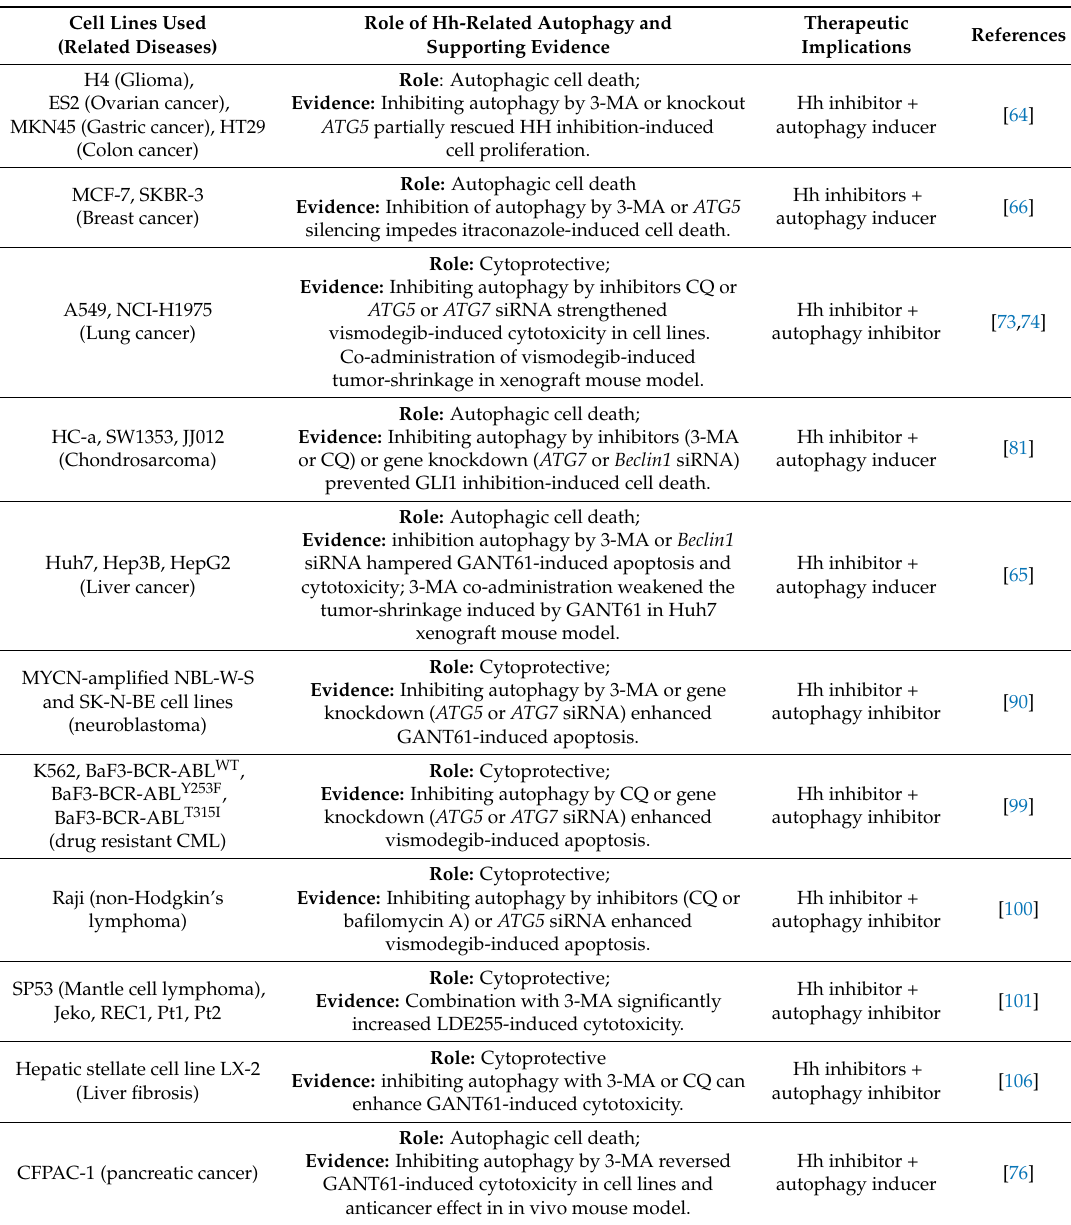
Table 4. A brief summary of studies that combined targeting Hh pathway and autophagy. Cell Lines Used Role of Hh-Related Autophagy and (Related Diseases) Supporting